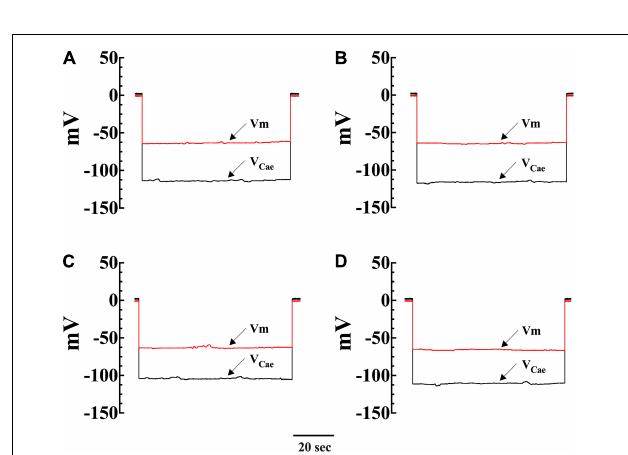
FIGURE 6 | Effects of SAR7334 on [Ca 2 + ] i in Wt and mdx VSMC. A typical response obtained with a conventional microelectrode (Vm) and a Ca 2 + -selective microelectrode (V Cae ) from a Wt and mdx VSMCs before and after SAR7334 (1 µ M) treatment. (A) shows the recording from a Wt VSMC before SAR7334 treatment (Vm: –63 mV and [Ca 2 + ] i 124 nM) and (B) after SAR7334 incubation (Vm: –64 mV and [Ca 2 + ] i 98 nM). The Vm and [Ca 2 + ] i measurements show in (A,B) were carried in the same smooth muscle cell. (C,D) represent the determination of Vm and [Ca 2 + ] i before (Vm –63 mV and [Ca 2 + ] i 280 nM) and after SAR7334 application (Vm: –64 mV and [Ca 2 + ] i 147 nM) in a mdx VSMCs. The Vm and [Ca 2 + ] i measurements in show (C,D) were carried in the same smooth muscle